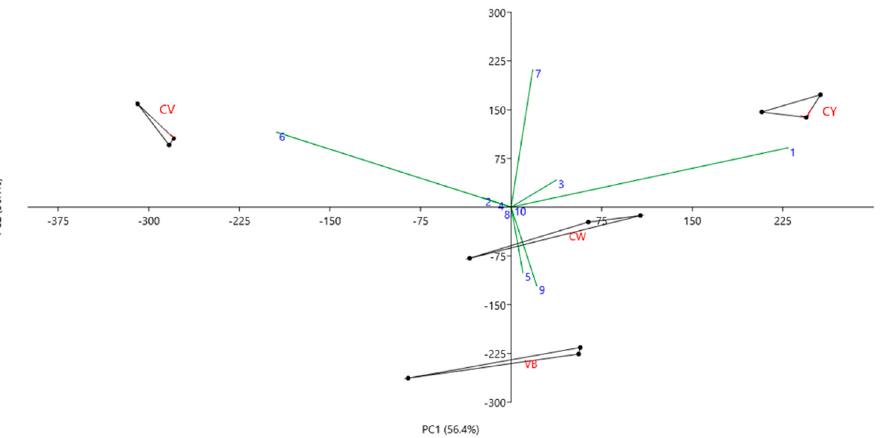
Figure 3. Principal component analysis (PCA)-biplot of V. calcarata subsp. calcarata white (CW), V. calcarata subsp. calcarata yellow (CY), V. calcarata subsp. calcarata violet (CV), and V. calcarata subsp. villarsiana (VB), calculated and drawn using PAST 4.03 software. 1. phenolic compounds; 2. anthocyanins; 3. hyperoside; 4. isoquercitrin; 5. quercitrin; 6. rutin; 7. ferulic acid; 8. ellagic acid; 9. epicatechin; 10. vitamin C.